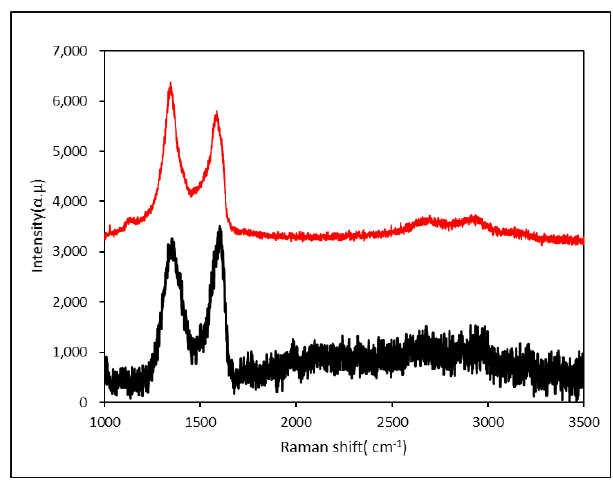
Figure 6. Raman spectra of the graphene oxide (GO) and activated graphene (JZGO).